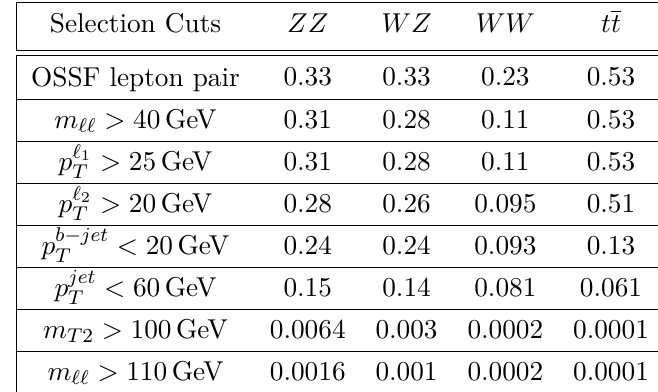
Table 3 . Cumulative efficiencies for the background events after applying the selection cuts √ corresponding to the analysis performed at s = 13 TeV for slepton searches [21]. Efficiencies are presented as the number of events which are selected over the number of initial events (see text for details).